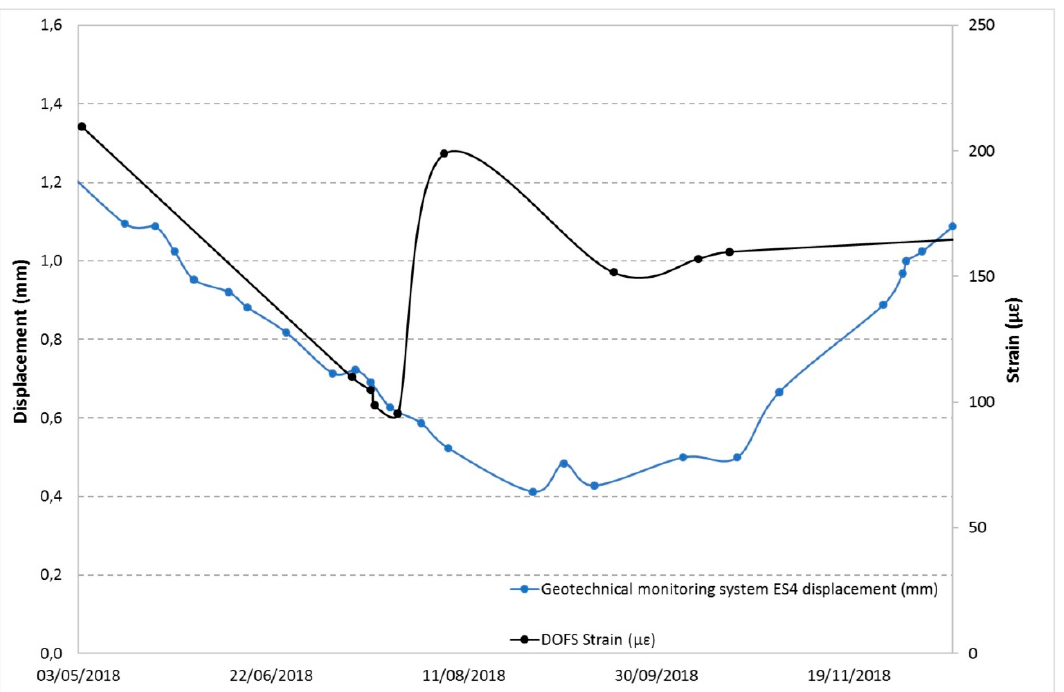
Figure 29. Comparison between the ES4 extensometer displacements and DOFS strain values in the same area.